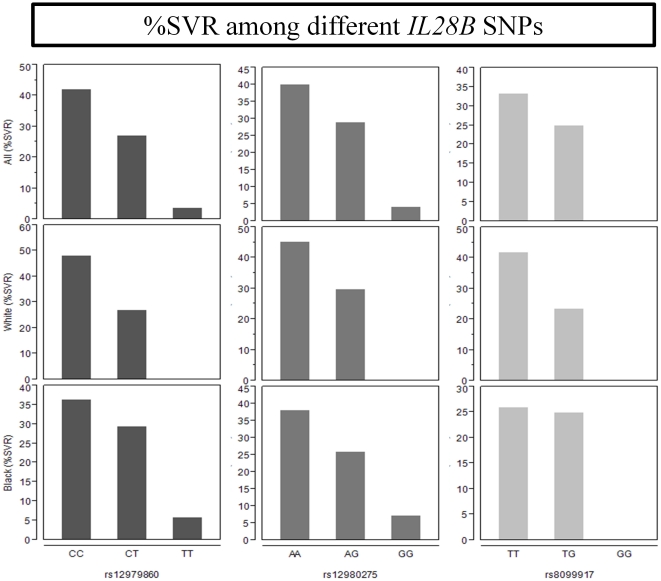
Bar graph showing percent of subjects with different IL28B SNPs achieving SVR stratified by ethnicity.